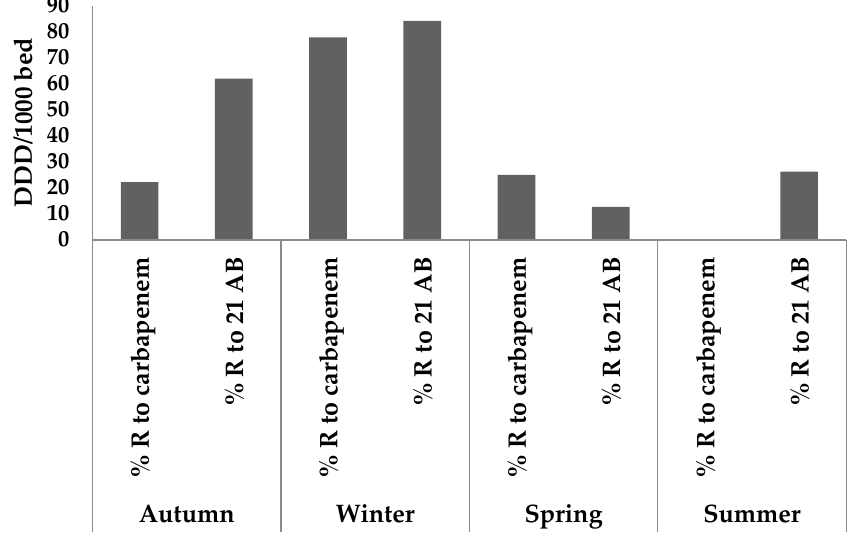
Figure 3. Graphical representation of the Predicted Environmental Concentration (PEC) ( ■ ) (in mg/L): in comparison with the percentage of Carbapenem-resistant bacteria CRB) ( ■ ) (in %) in MCH.